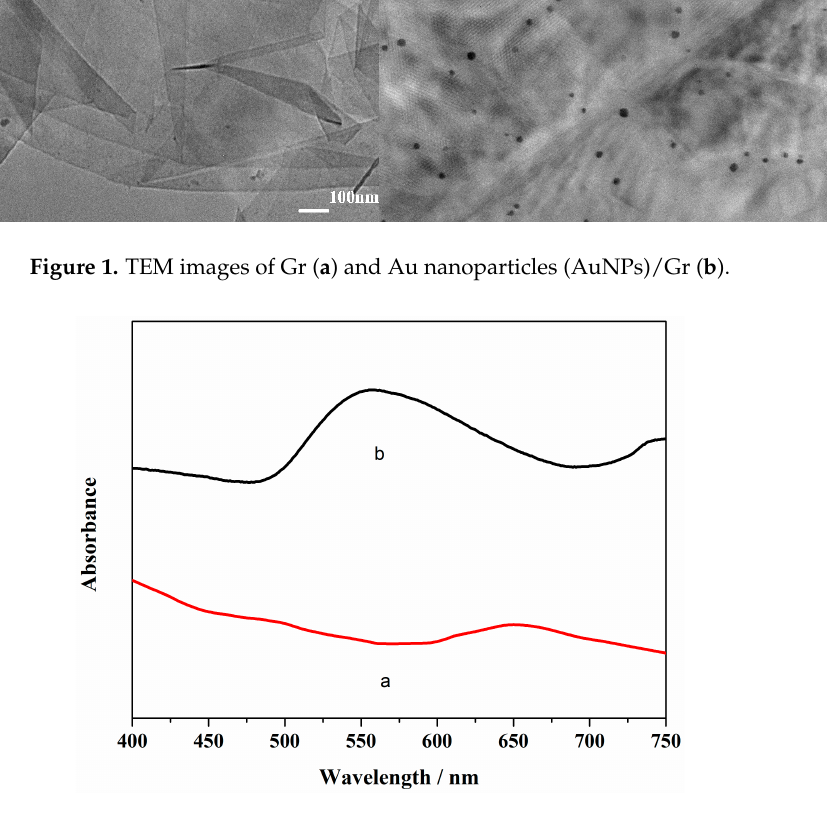
Figure 2. UV-vis absorption spectra of ( a ) Gr and ( b ) AuNPs/Gr.